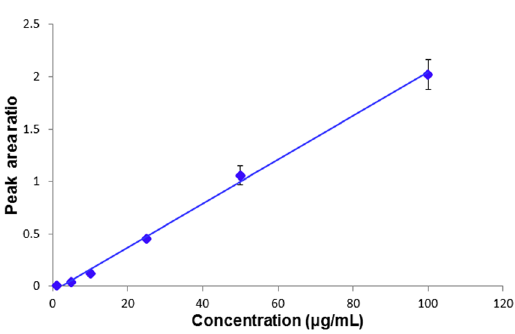
Figure 4. Calibration curves for analysis of ibuprofen spiked in human plasma under the optimized micro- labeling